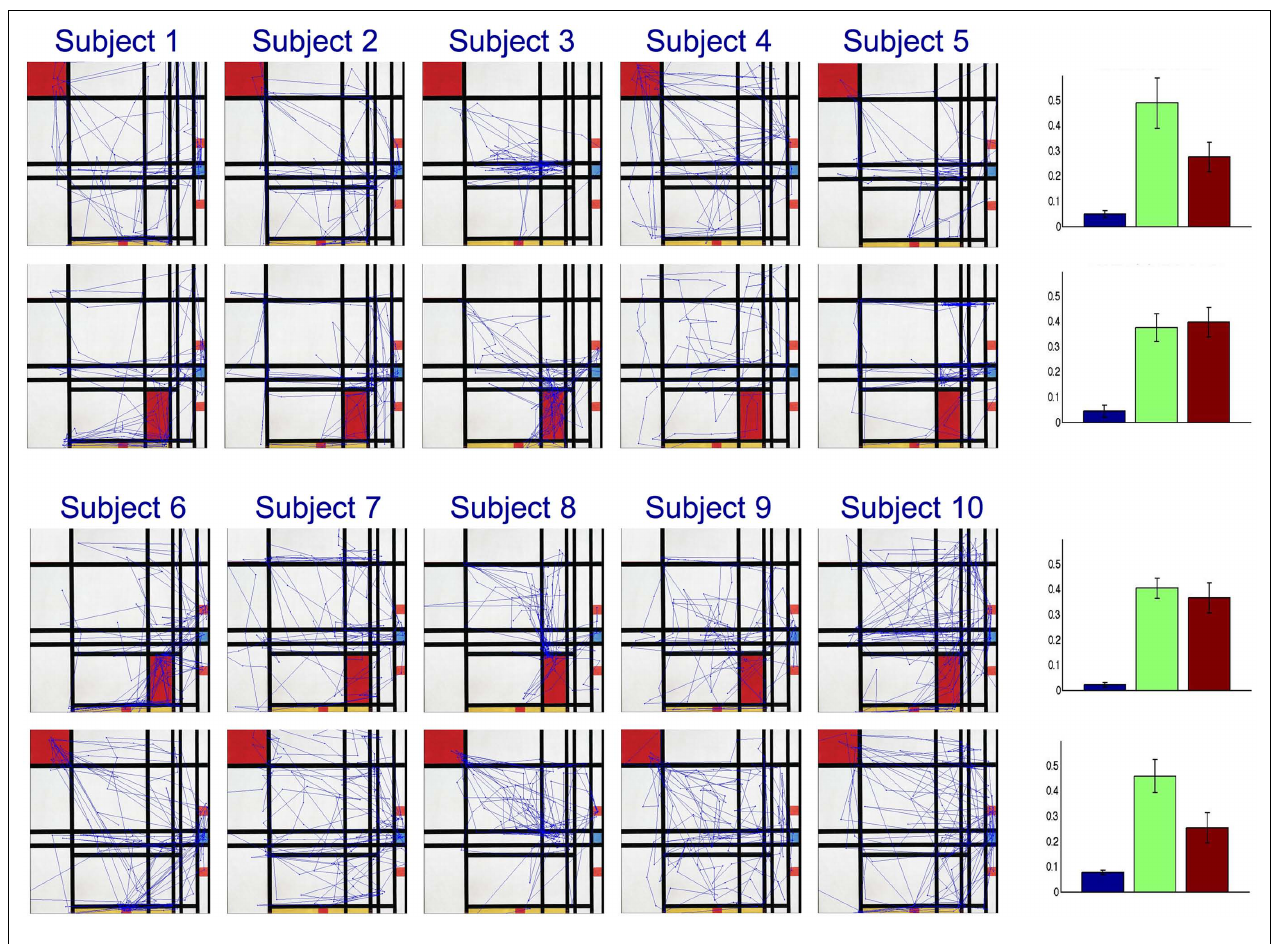
the original (modified) version first.The graphs on the right of each row show the average relative number of fixations in each region of interest for the five